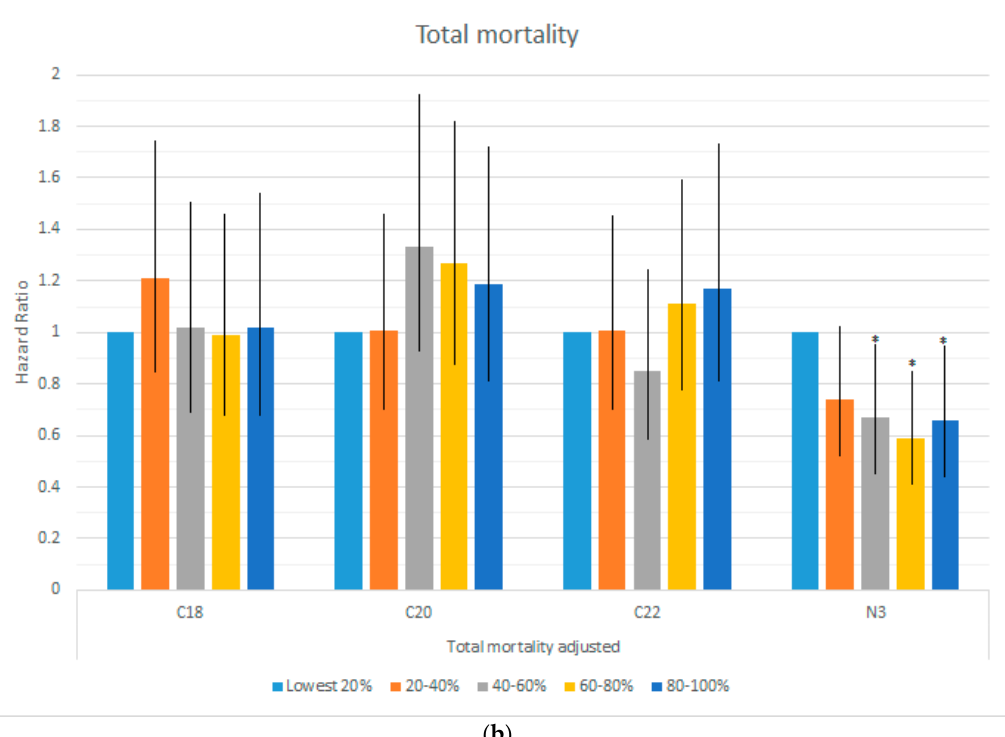
Figure 1. ( a ) Hazard ratios for total cardiovascular (CVD) risk by n-6 FAs and the omega-3 index. Figure 1a illustrates the associations between n-6 or n-3 fatty acids and total CVD risk. Bar heights are hazard ratios with 95% confidence intervals provided for each hazard ratio. Hazard ratios